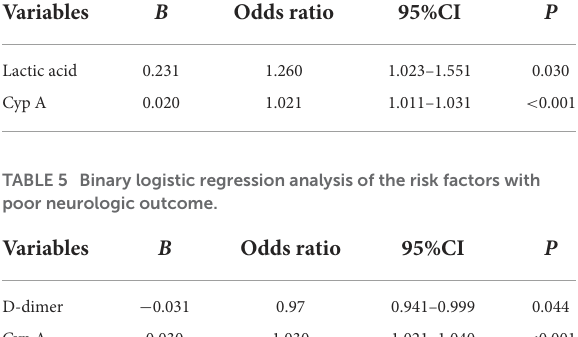
TABLE 4 Binary logistic regression analysis of the risk factors for death of craniocerebral traumatic patients. Variables